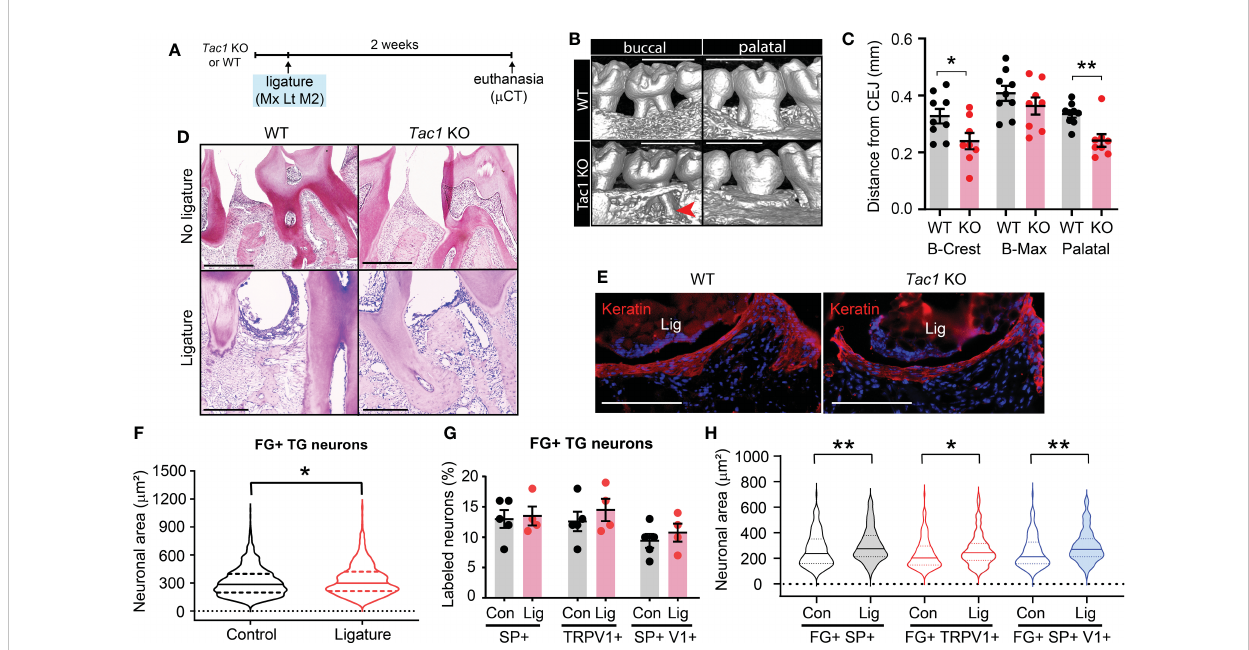
FIGURE 2 Knockout of Tac1 reduces ligature-induced bone loss. (A) Time course of the experiments. Mx, Maxilla; Lt, left side ligature. (B) µCT examination of the effect of Tac1 KO on bone loss two weeks after ligature placement. Arrowhead, fenestration of buccal alveolar bone on the distobuccal root of M2. Scale bar, 1 mm. (C) Quanti fi cation of bone loss. *p < 0.05, **p<0.01 in Student ’ s t-tests. N=9 in WT and 8 in KO. (D) H&E staining of decalci fi ed periodontia of WT and Tac1 KO with (bottom) or without ligature (top). Scale bar, 200 µm. (E) Immunohistochemical labeling of pan- cytokeratin (red) in WT and Tac1 KO 5 days after ligature. Blue, DAPI. Scale bar, 200 µm. Lig, ligature. (F) Violin plots comparing the frequency distribution of FG+ neuronal areas in TG from C57bl/6 mice in control and ligature side (N=1,234 neurons from fi ve TG in control; N=779 from four TG in ligature group). Solid line within the plot, median; dotted lines, quartiles. *p<0.05 in Mann-Whitney test. (G) Proportions of SP+, TRPV1 +, or SP+/TRPV1+ neurons among FG+ TG neurons in the control (Con) and the ligature (Lig) group. Each point indicates a proportion in a ganglion. N=5 in the control and 4 in the ligature group. 151 to 428 FG-labeled neurons per ganglia were quanti fi ed. (H) Violin plots comparing the size distribution of FG+/SP+ (black), FG+/TRPV1+ (red), or FG+/SP+/TRPV1+ (blue) neurons in the control (Con) or the ligature (Lig) group (N=159, 106, 147, 118, 111, and 85 neurons). Solid line within the plot, median; dotted lines, quartiles. * p<0.05; **p<0.01 in Mann-Whitney test.